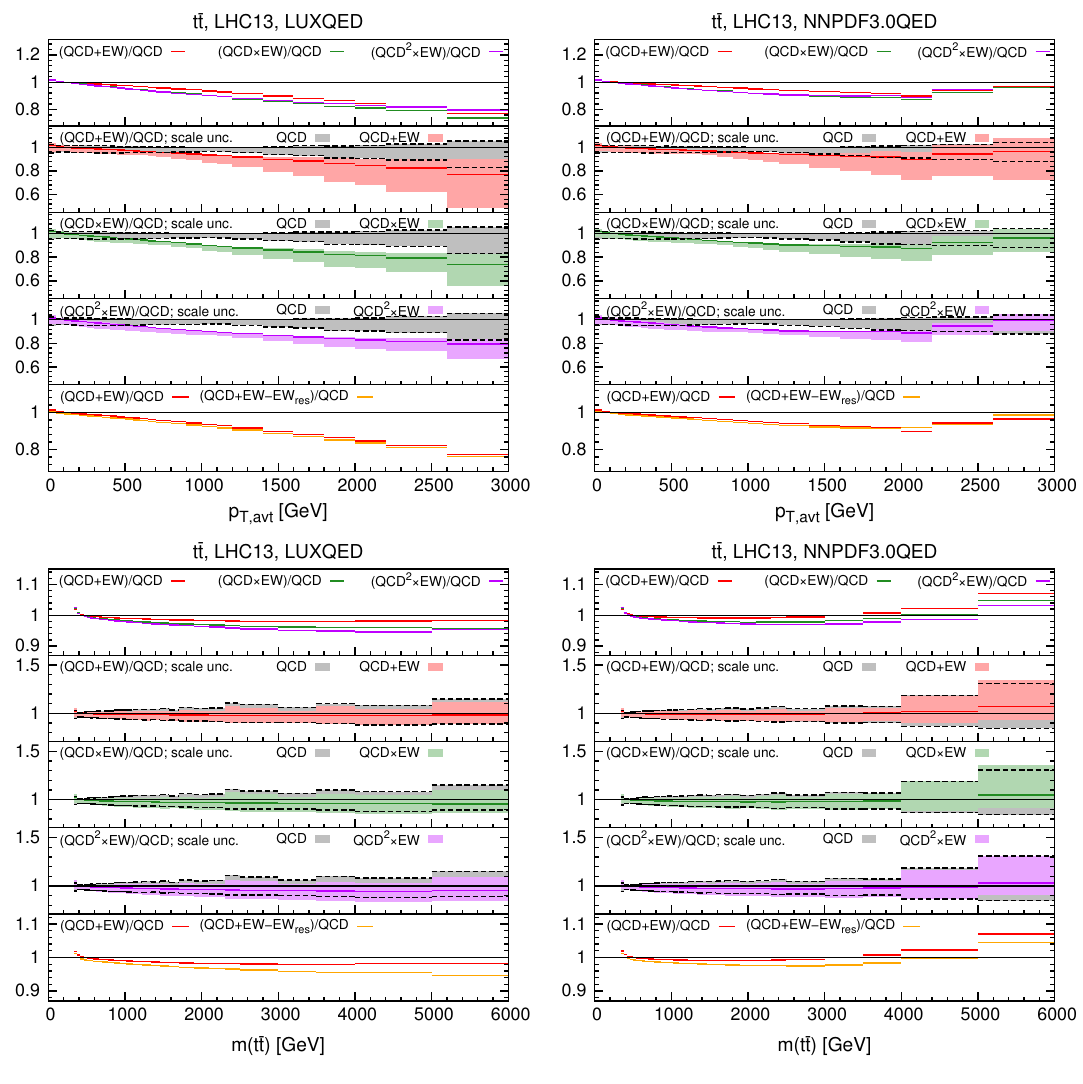
Figure 4 . Additive ((cid:6) QCD+EW ) versus multiplicative ((cid:6) QCD (cid:2) EW ) approach: p T; avt and m ( t (cid:22) t ) di(cid:11)erential distributions at 13 TeV. The format of the plots is described in the text. three alternative predictions: (cid:6) = (cid:6) (red line), (cid:6) = (cid:6) (green line) QCD+EW QCD QCD (cid:2) EW QCD and (cid:6) = (cid:6) (violet line). These quantities are further displayed in the second, QCD QCD 2 (cid:2) EW third and fourth inset, respectively, where not only the central value but also the scale dependence of the numerator is shown. In all cases we calculate the scale-uncertainty band as a scale-by-scale combination and subsequent variation in the 7-point approach. Scale variation bands have the same colour as the corresponding central-value line. For comparison we also display (grey band) the relative scale uncertainty of (cid:6) . Thus, the QCD second inset is exactly the same as the second inset in the corresponding plots in section 3.1. The last inset shows a comparison of the ratio (cid:6) = (cid:6) including (red line) or not QCD+EW QCD (orange line) the contribution (cid:6) , where \res" stands for residual and denotes the fact res that (cid:6) are contributions to (cid:6) that are expected to be small, regardless of the PDF res EW set used (see eq.